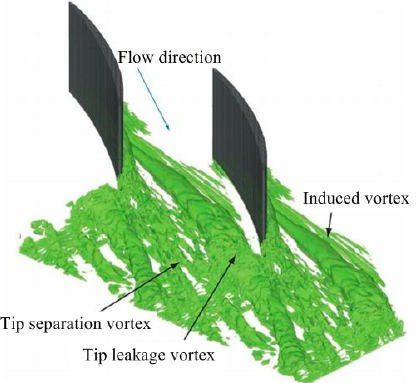
Figure 14. Three-dimensional structure of tip-clearance flow based on large eddy simulation (LES) [36].